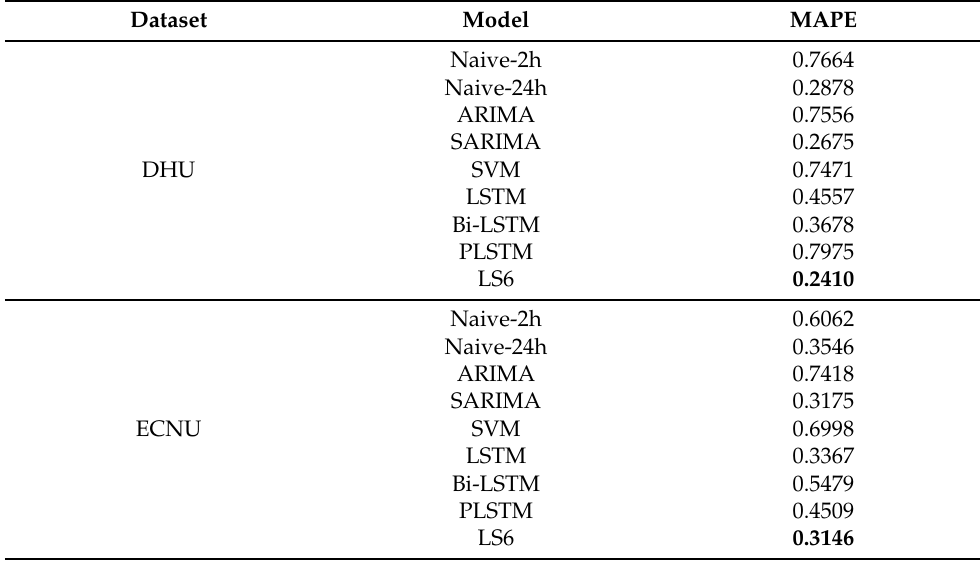
Table 3. Prediction performance of LS6 and baseline methods on different